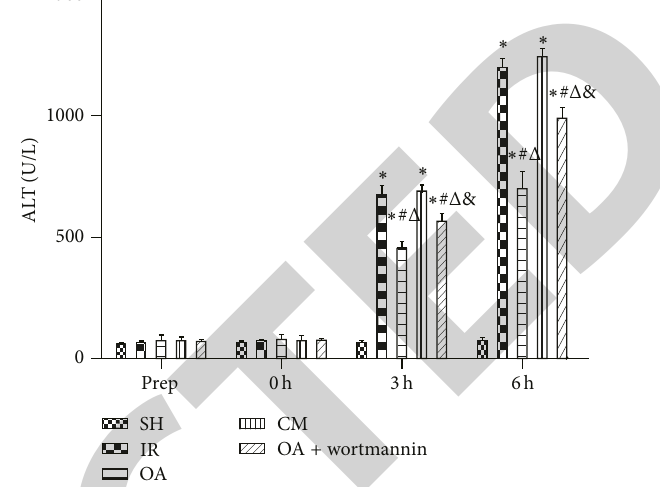
Figure 2: Effects of pretreatment with OA on the activity of ALT in rats induced by partial hepatic IR. Data are represented as means ± SD ( 𝑛 = 8 ). ∗ 𝑃 < 0.05 , compared with group SH. # 𝑃 < 0.05 , compared with group IR. Δ 𝑃 < 0.05 , compared with group CM. & 𝑃 < 0.05 , compared with group OA.